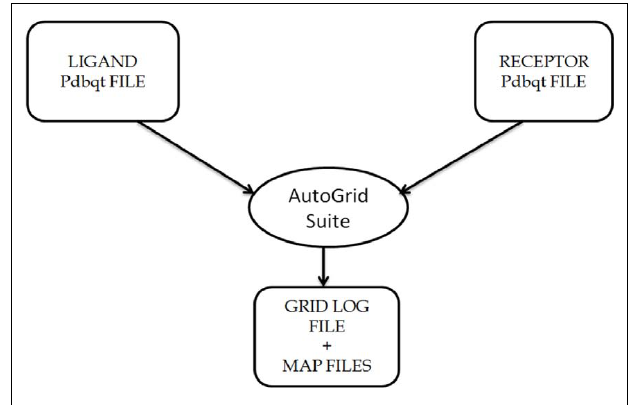
FIGUREA1 | Description of the usage ofAutoGrid Suite in the AutoDock4 software package, that generates map files specifying the area over the surface of protein for ligand binding on the basis of information provided in GPF files, i.e., Grid Parameter file.